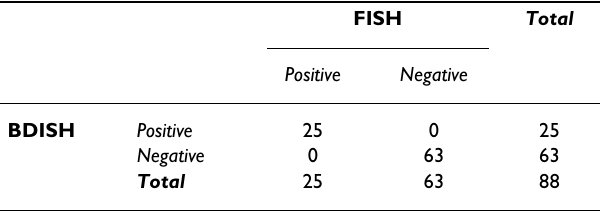
Table 3: Performance of brightfield double in situ hybridization (BDISH) with clinical samples based on the ASCO/CAP method without 4 FISH equivocal